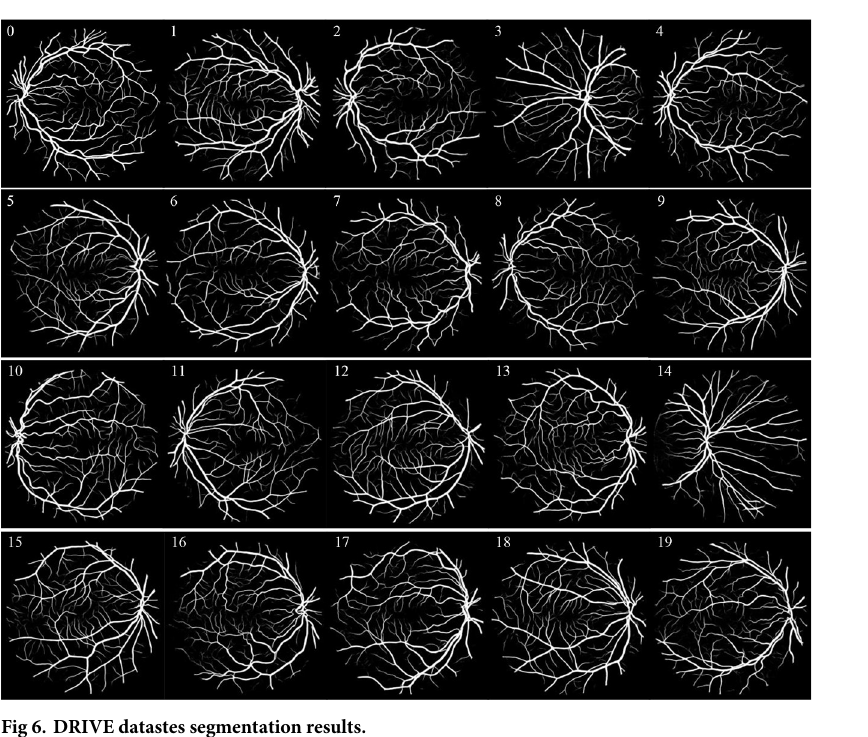
Fig 6. DRIVE datastes segmentation results.